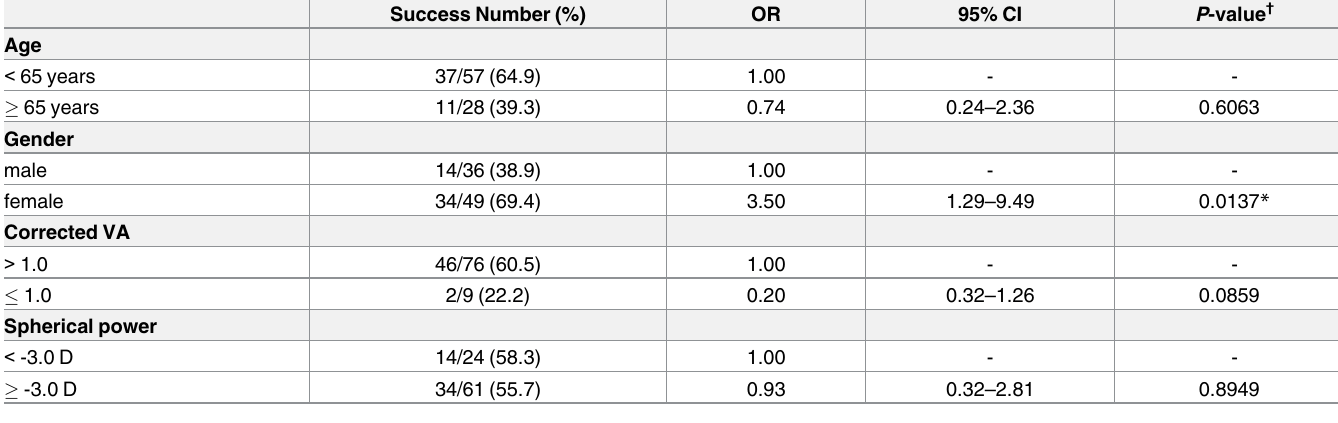
Table 3. Results of multivariate logistic regression analysis for predicting the successof drop instillation in non-glaucoma subjects (n =